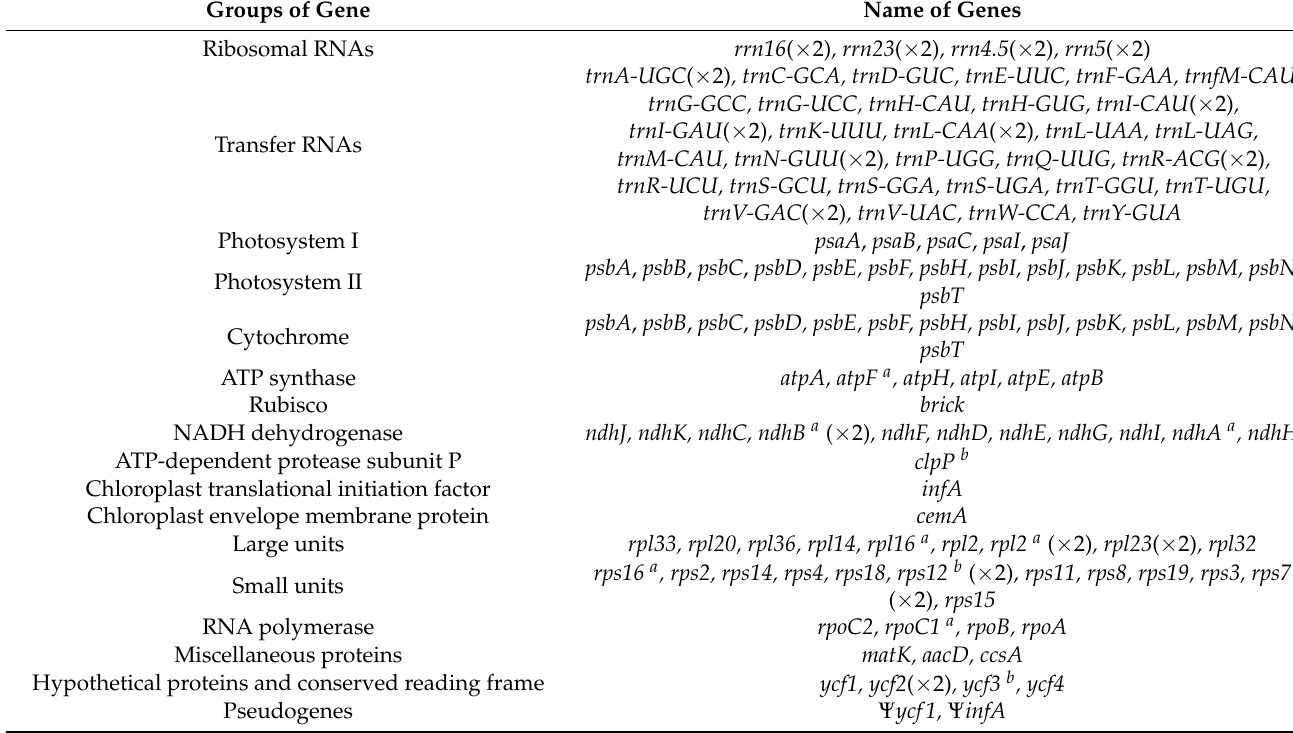
Table 2. Gene list of the Convallaria chloroplast